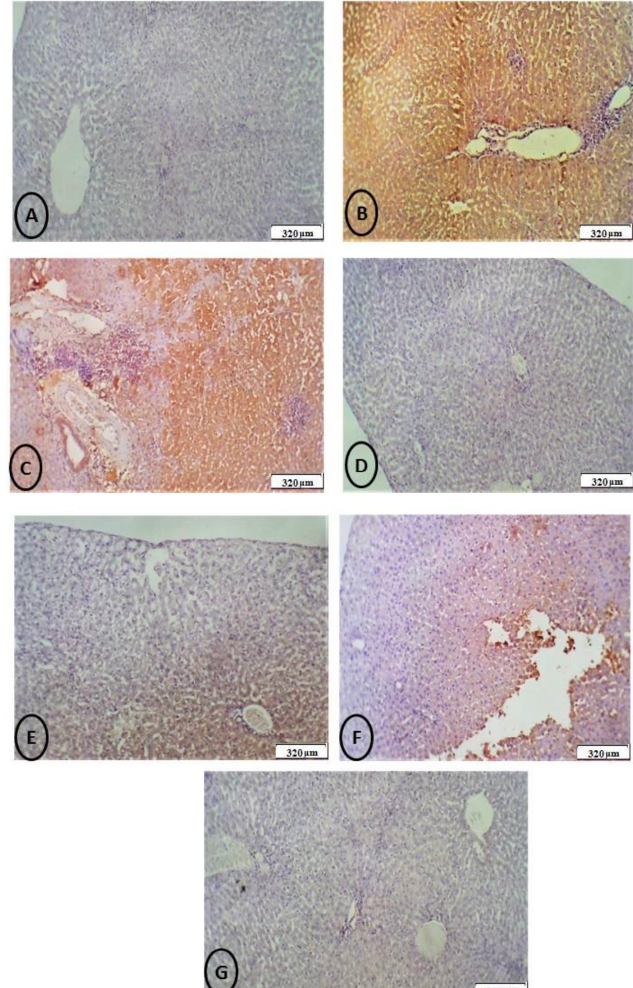
Figure 11. ( A ) Control group: photomicrograph of a cross-section of the hepatic tissues of the control group showing (-Ve) negative caspase-3 immunostaining (+) (weak immunoreactivity) (320 µ m). ( B ): Photomicrograph of a cross-section of the hepatic tissue after administration of MoO 3 -NPs showed marked cytoplasmic hepatocyte staining of caspase-3, indicating marked apoptosis and toxicity in hepatocytes with sparing of the portal triad and inflammatory cells (++++) (very strong immunoreactivity) (320 µ m). ( C ) Photomicrograph of a cross-section of the hepatic tissue after admin- istration of CdCl 2 showing strong (marked) cytoplasmic hepatocyte staining of caspase-3, indicating severe apoptosis resulting from toxicity in hepatocytes, without staining of nuclei, portal triad, or inflammatory cells (++++) (very strong immunoreactivity) (320 µ m). ( D ) Photomicrograph of a cross- section of the hepatic tissues of RJ treated group showed negative hepatocyte staining of caspase-3 in hepatocytes, indicating the absence of toxicity (++++) (very strong immunoreactivity) (320 µ m). ( E ) Photomicrograph of a cross-section of the hepatic tissues after administration of MoO 3 -NPs and RJ showed moderate cytoplasmic caspase-3 immunostaining (++) (moderate immunoreactivity) (320 µ m). ( F ) Photomicrograph of a cross-section of the hepatic tissues after administration of a combination of CdCl 2 and RJ showing moderate cytoplasmic caspase-3 immunostaining (++) (mod- erate immunoreactivity) (320 µ m). ( G ) Photomicrograph of a cross-section of the hepatic tissues of the group treated with a combination of MoO 3 -NPs and CdCl 2 with RJ showed mild to moderate caspase-3 immunostaining (+) (weak immunoreactivity) (DAB chromogen, Meyer’s hematoxylin counterstain) (320 µ